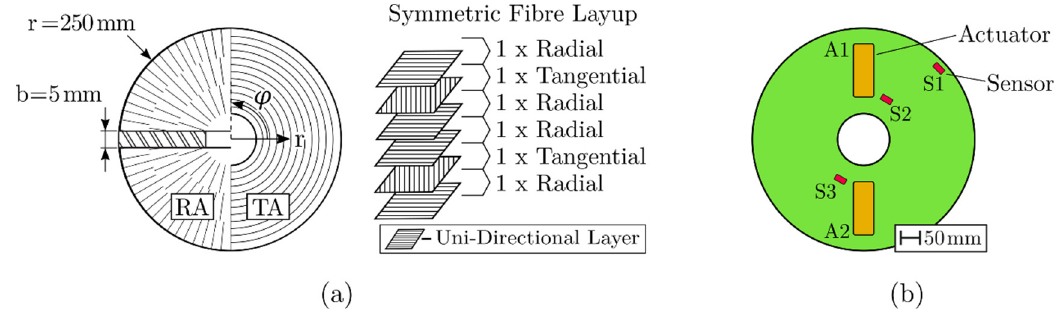
Figure 2. Fibre alignment and dimensions of the radial and tangential sub-preform types with the total layup of the GFRP rotor ( a ). Placement of the actuators and sensors ( b ).